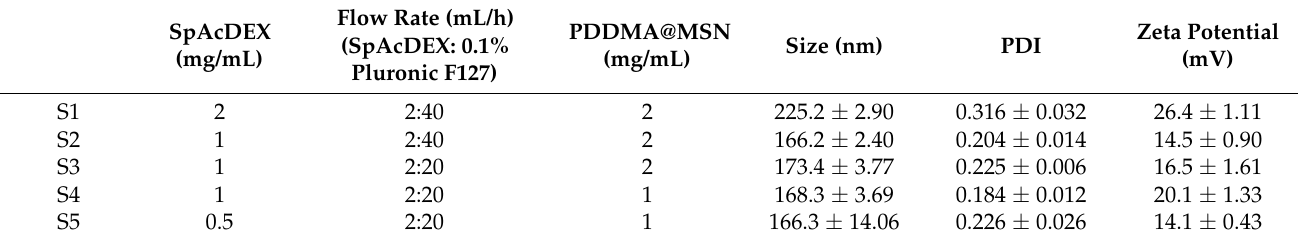
Table 2. Microfluidic parameters for SpAcDEX coating and the resulting characterization